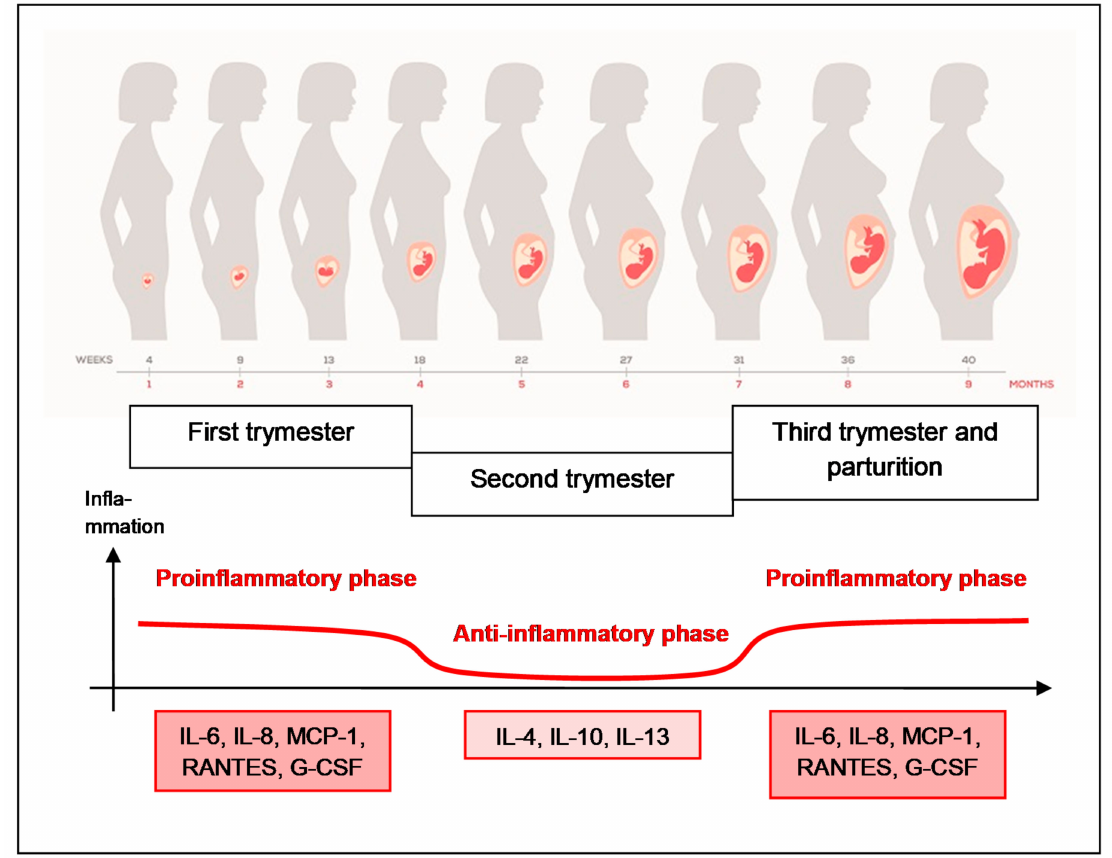
Figure 4. Immune response in normal pregnancy. Pregnancy may be divided into three immunologically different phases: the first trimester with inflammatory processes conditioned by proinflammatory cytokines and chemokines (IL-6, IL-8, MCP- 1, RANTES, G-CSF), the second trimester with silencing of inflammatory reactions thanks to anti-inflammatory cytokines (IL-4, IL-10, IL-13) and the third trimester with the inflammation intensified again due to the activity of proinflammatory factors conditioning the proper course of delivery and